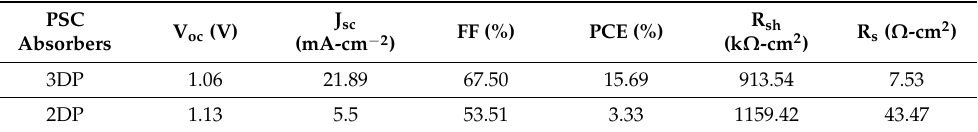
Table 1. Summary of optimized photovoltaic parameters used for the n-i-p PSCs fabricated, as shown in Figure 4, based on the 3DP (MAPbI 3 ) and 2DP ((CH 3 (CH 2 ) 3 NH 3 ) 2 (CH 3 NH 3 ) 3 Pb 4 I 13 ) solar cell